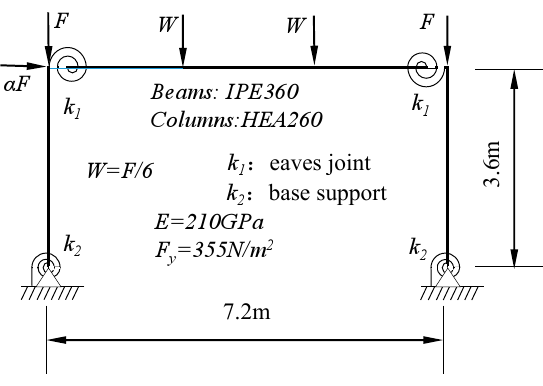
Figure 13. A steel portal frame with semi-rigid connections and supports.